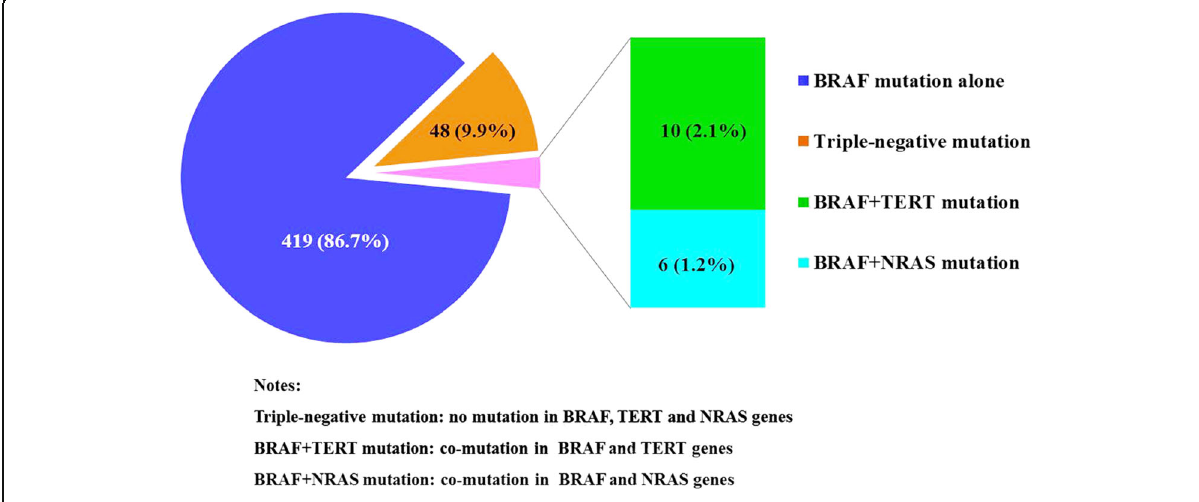
Fig. 1 Distribution of BRAF V600E, TERT, NRAS